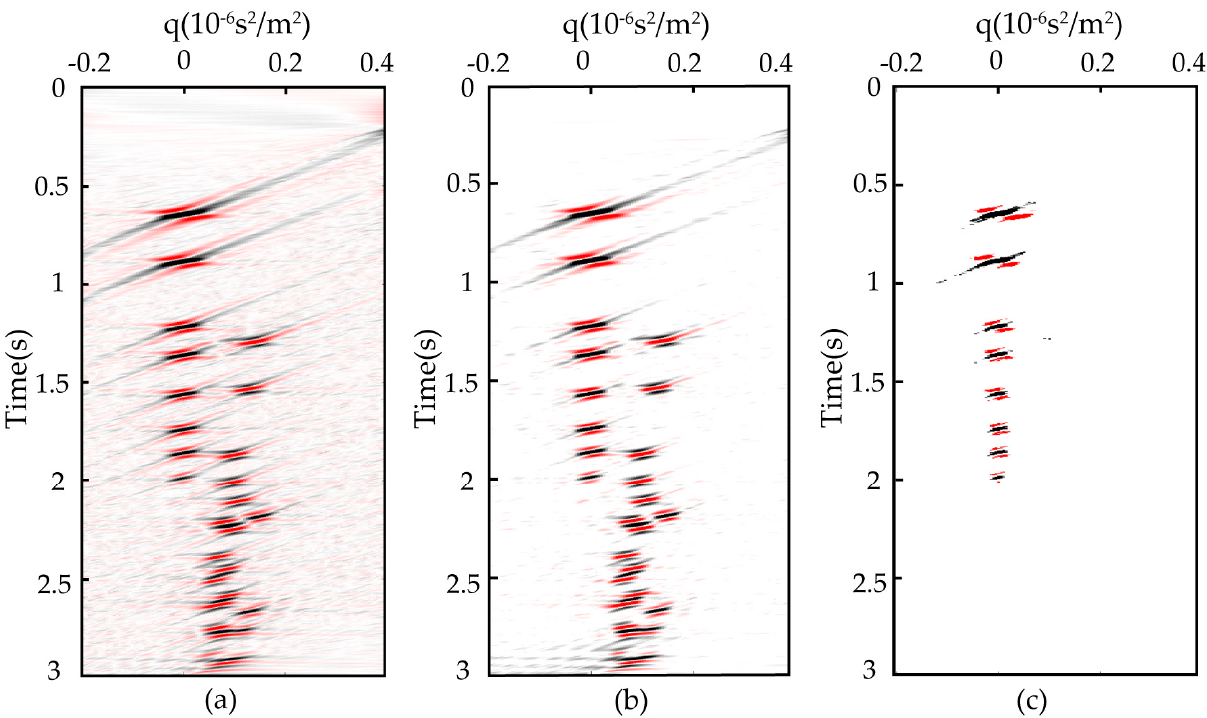
Figure 4. Radon domain results: ( a ) LSPRT method; ( b ) SPRT L 1 method; ( c ) SPRT L q 1 − L q 2 method.